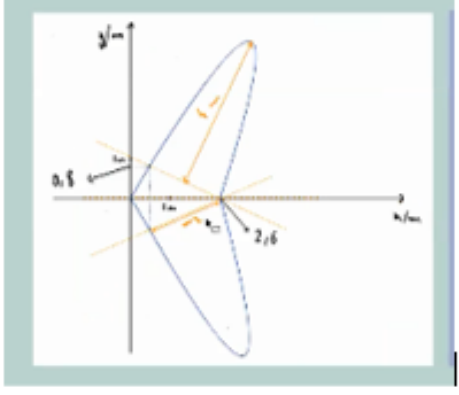
Figure 9. Hang-glider shape using parabolas and triangles.